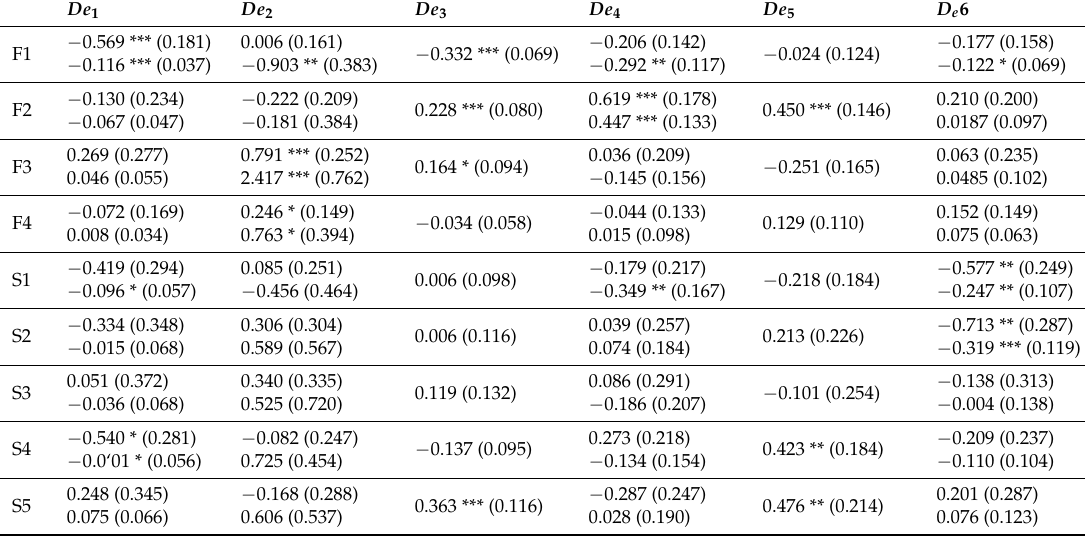
Table A3. Estimation results of the ordered logit and tobit models (part